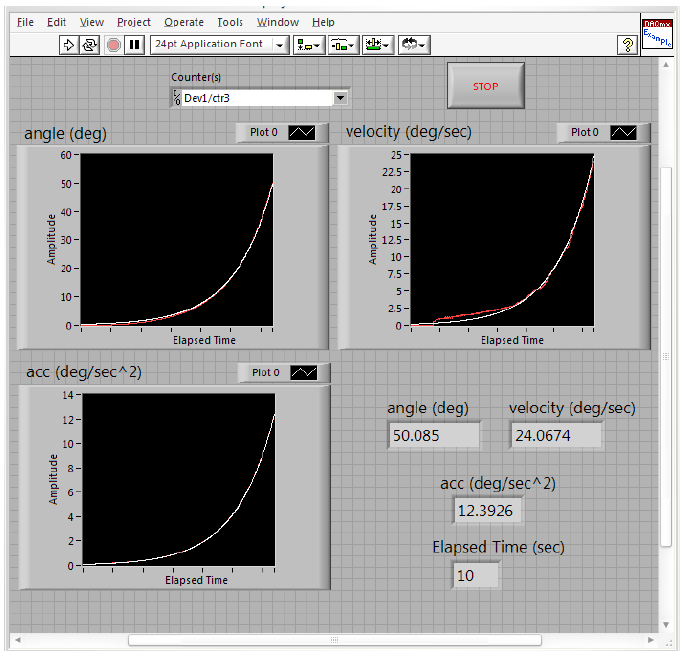
Figure 18. The values of the estimated and measured angular position, velocity and acceleration of the second joint angle (white: estimated, red: